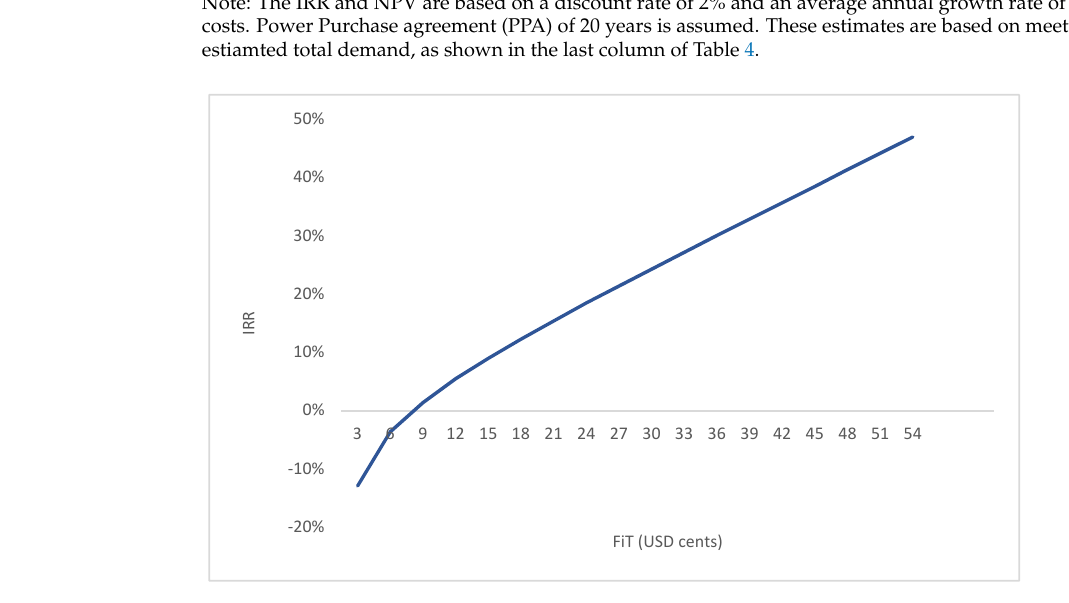
Figure 8. IRR for each give FiT. FiTs larger than 8.1 cents provide a positive IRR.